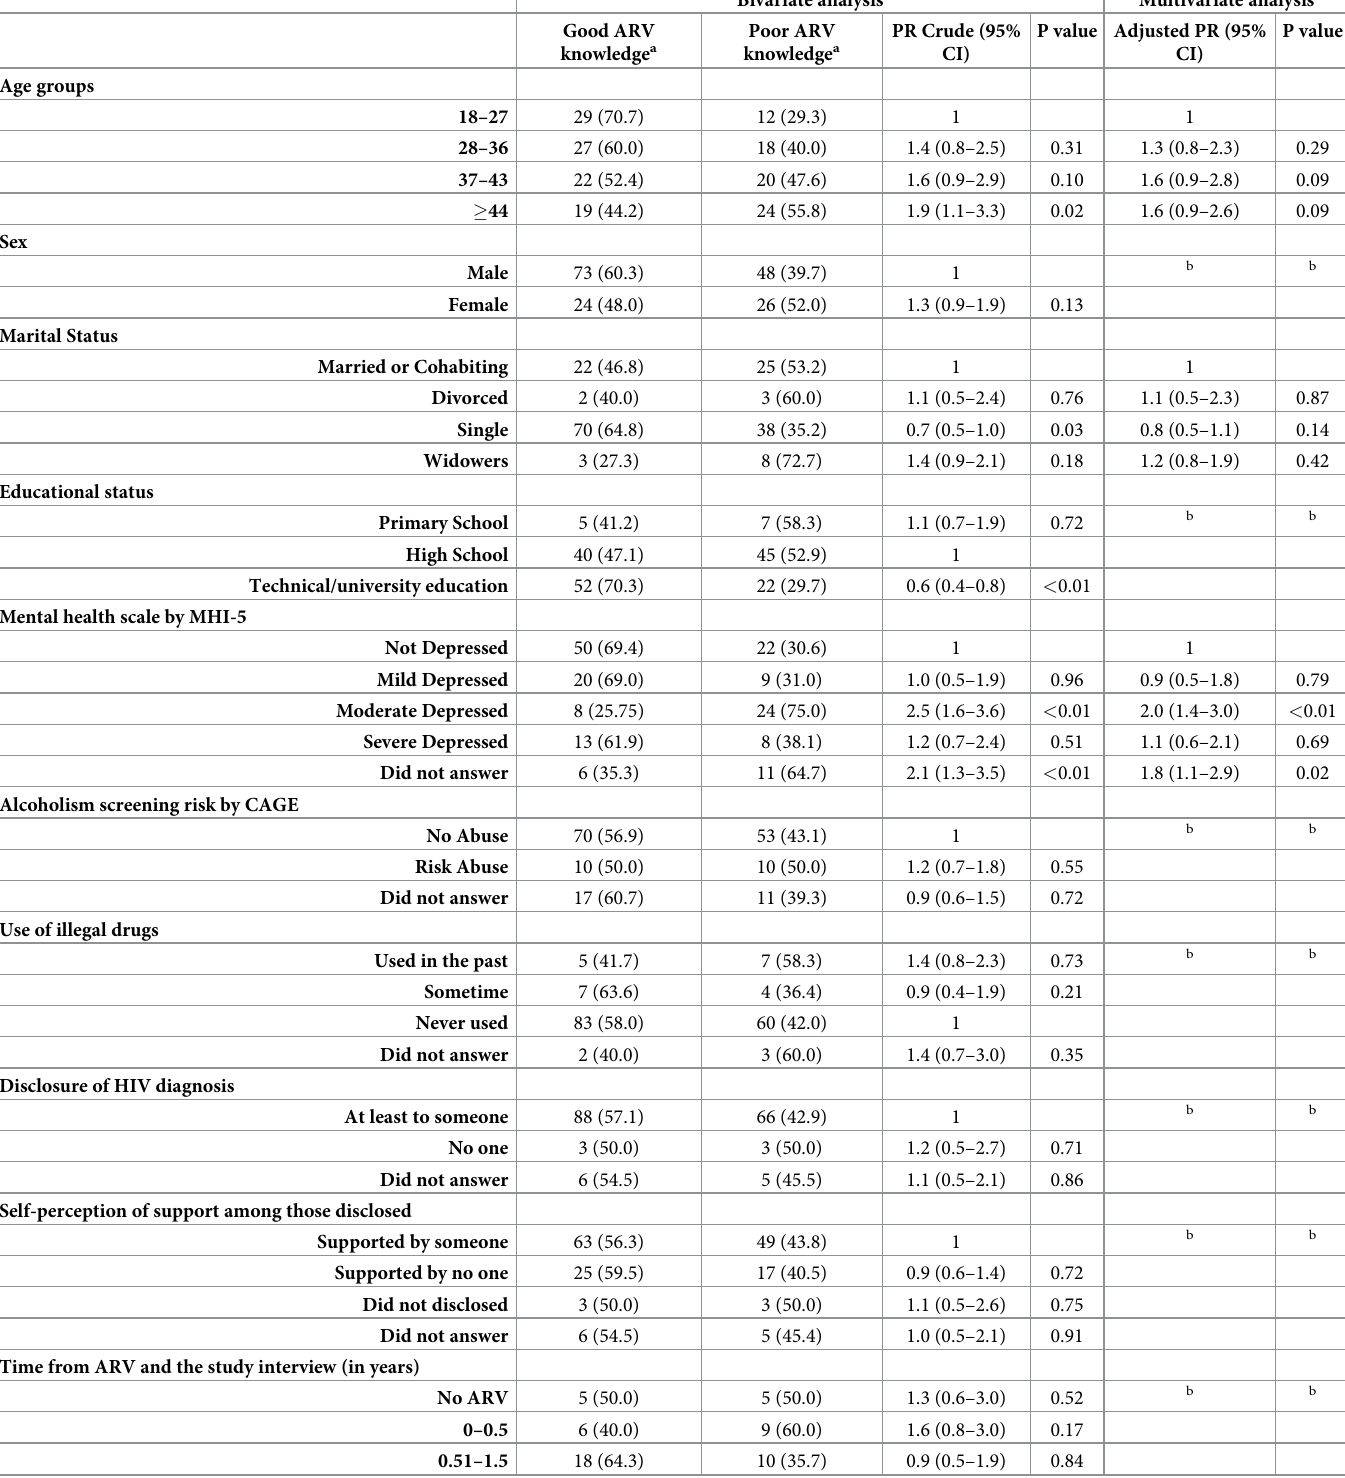
Table 3. Bivariate and multivariate analysis of determinants of antiretroviral (ARV) knowledge, among people living with HIV in a referral center in Lima, Peru, 2016–2017 (N =